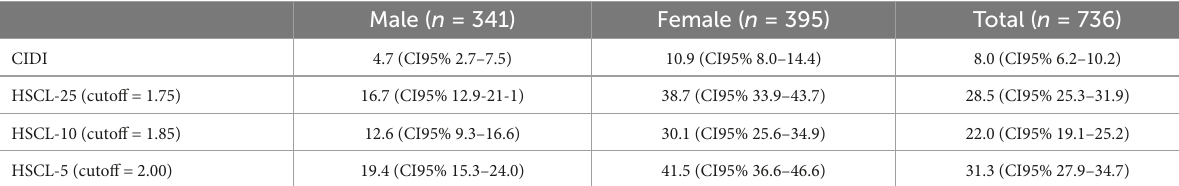
TABLE 5 Prevalence of depression according to CIDI, HSCL-25, HSCL-10, and HSCL-5, total and by